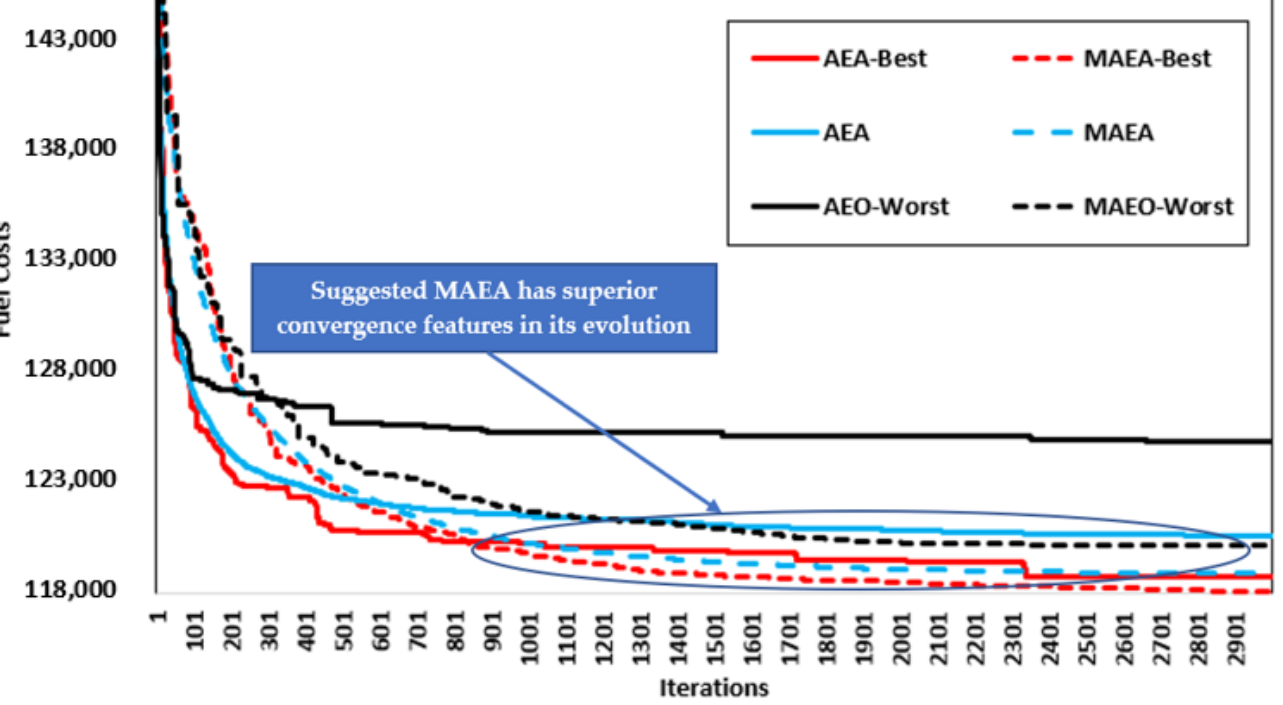
Figure 14. Convergence rates of the proposed MAEA and the basic AEA of Case 4.